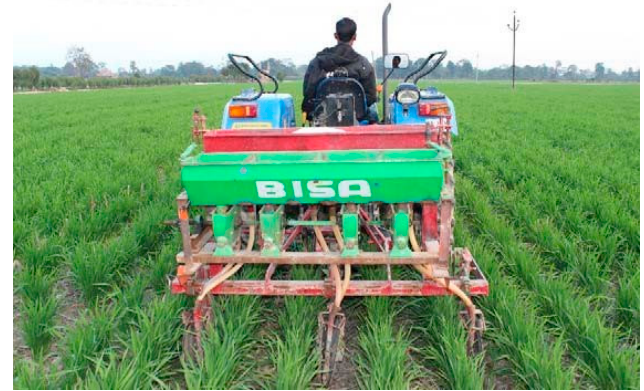
Figure 2. Disc bed planter developed at CIMMYT-BISA farm, Bihar.